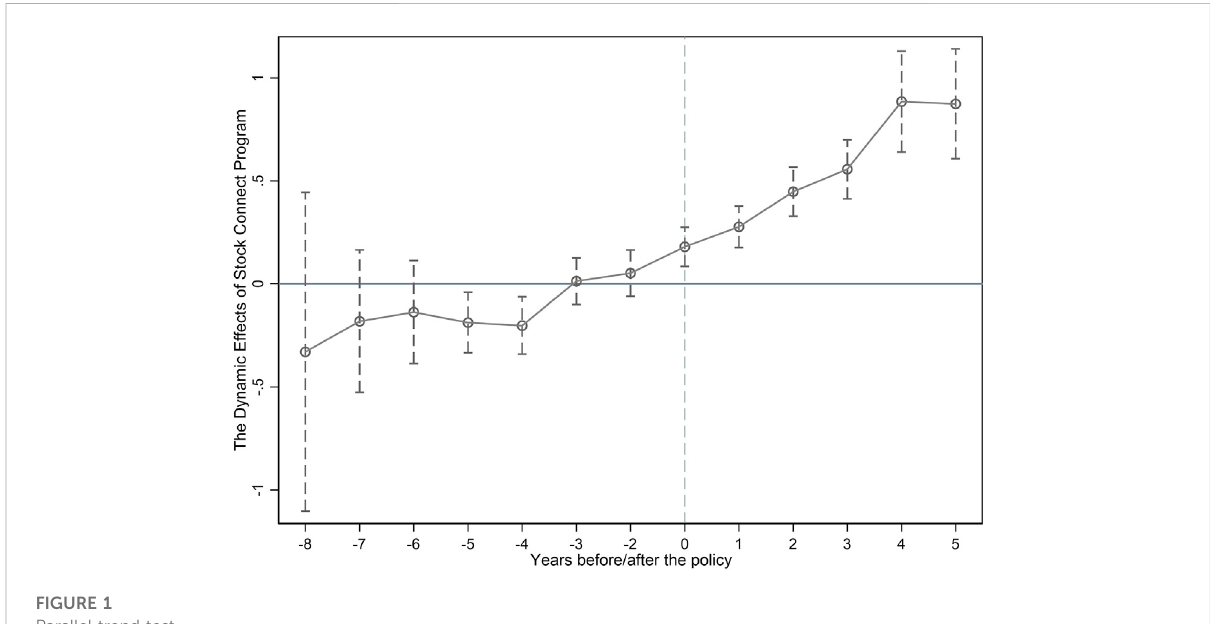
FIGURE 1 Parallel trend